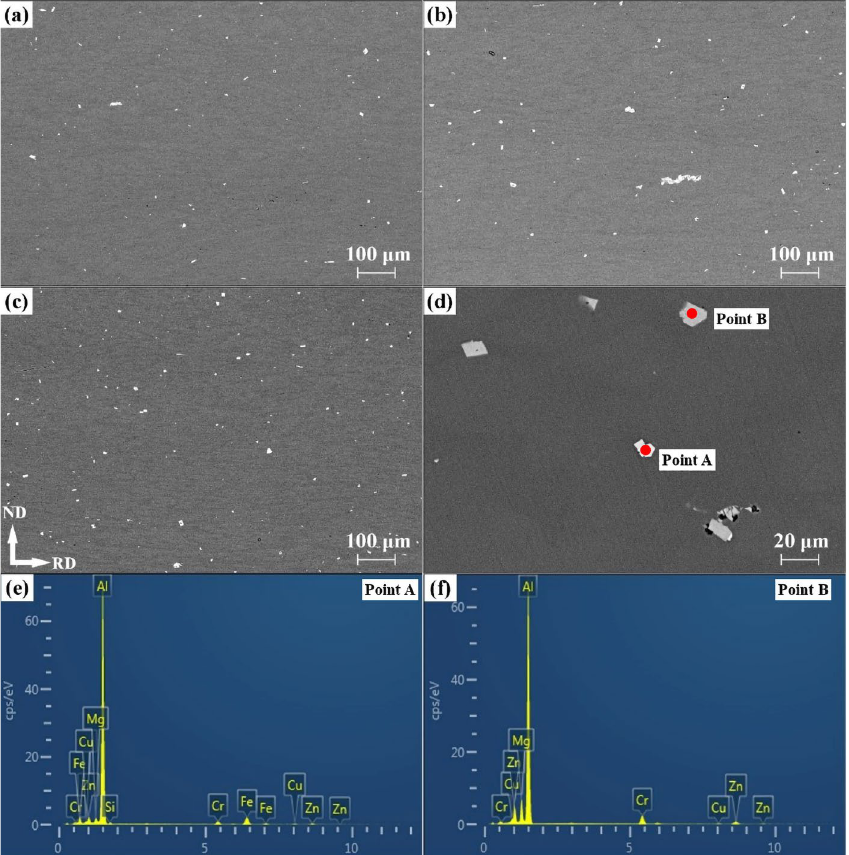
Figure 5. SEM images of Al-5Zn-2.6Mg-xCu alloys with different Cu contents: ( a ) x = 0.24 wt.%, ( b ) x = 0.43 wt.%, ( c ) x = 0.91 wt.%. ( d ) Local amplification. Energy spectrum analysis of white ( e ) and gray ( f ) phases in ( d ). Table 3. Chemical composition of secondary phase in Al-5Zn-2.6Mg-xCu alloy (wt.%). Alloy Zn Mg Cu